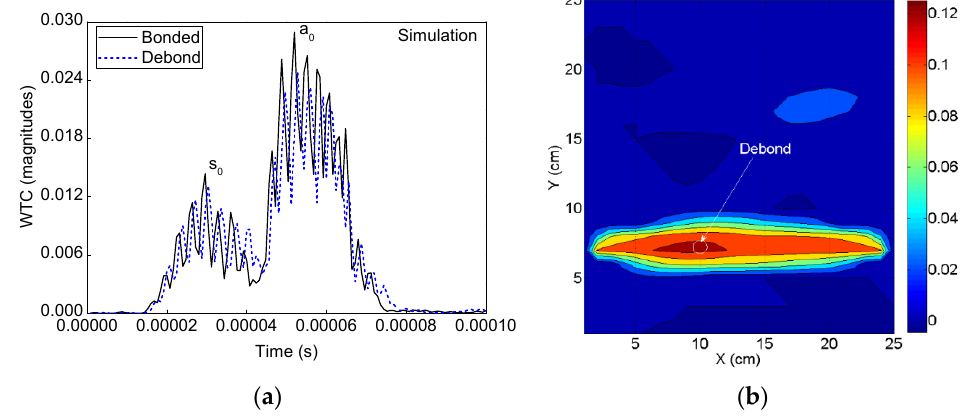
Figure 11. Numerical simulation: ( a ) A typical comparison between the WTs of bonded and debond-influenced signals (Figure 7) and ( b ) debond index map showing the identified debond location in the ACCS.